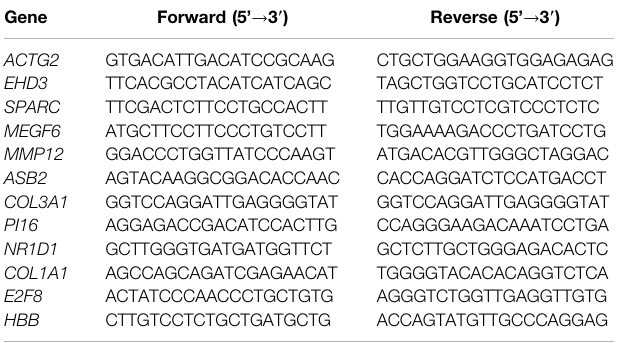
TABLE 1 | Primers used for the RT-qPCR